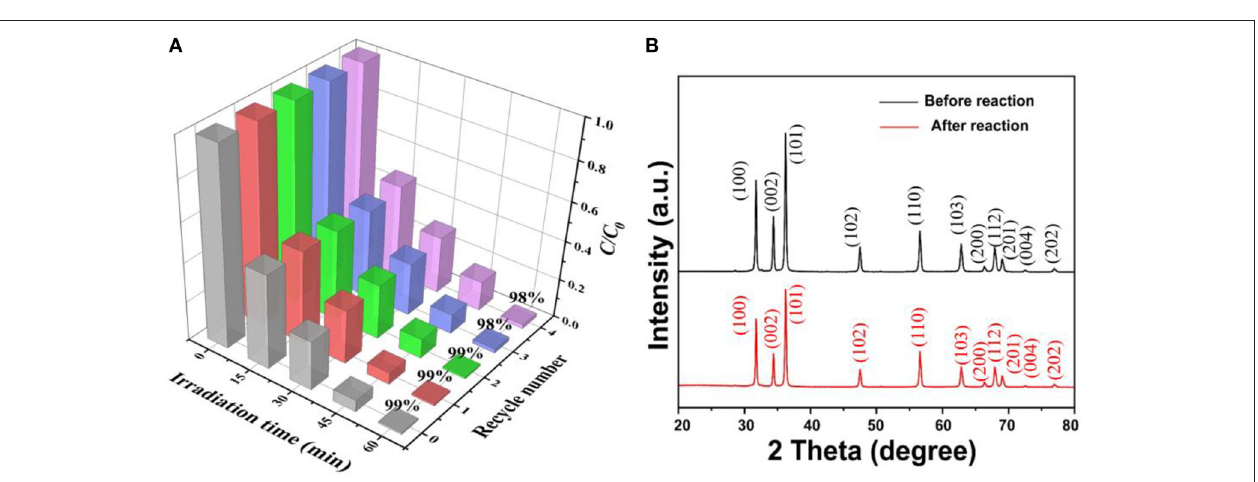
no signal is found in the dark. These results revealed that · OH and · O − were formed for the photocatalytic degradation of BPA are 2 2 over the as-fabricated ZnO